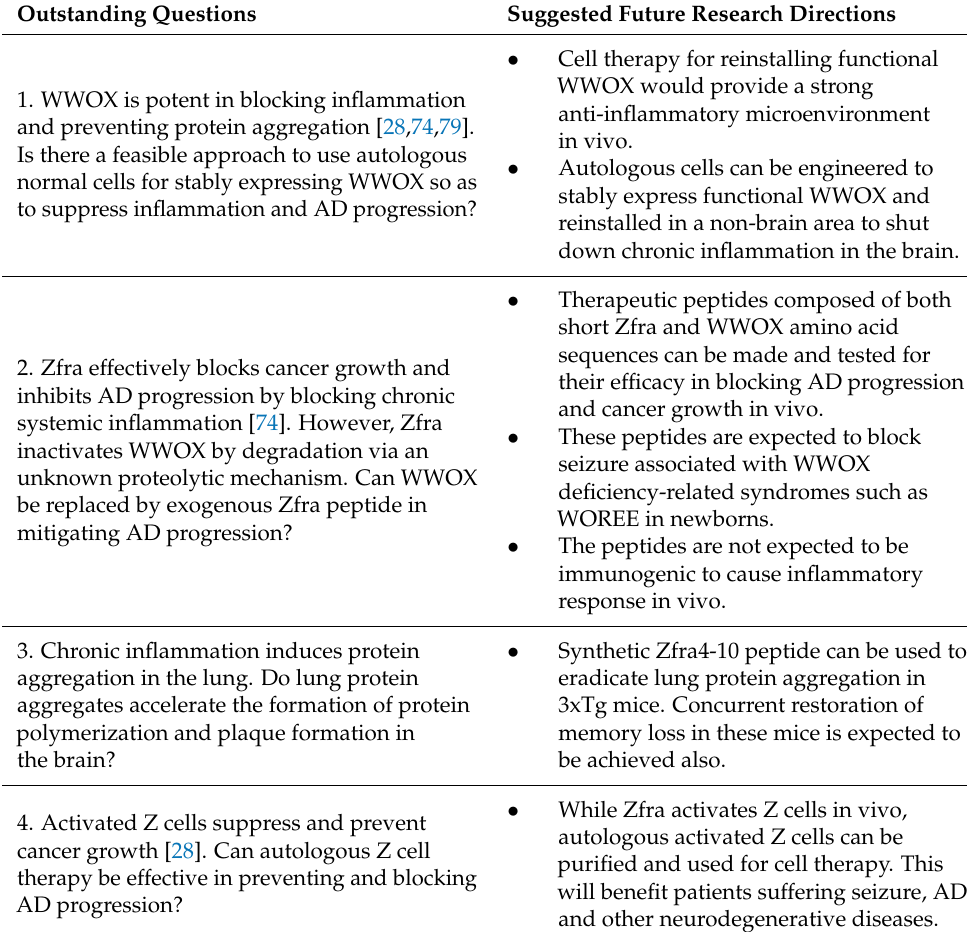
Table 1. Outstanding questions and future research